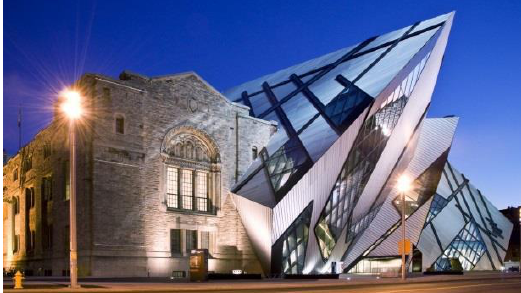
Fig. 34 Royal Ontario museum, Toronto (Libeskind,